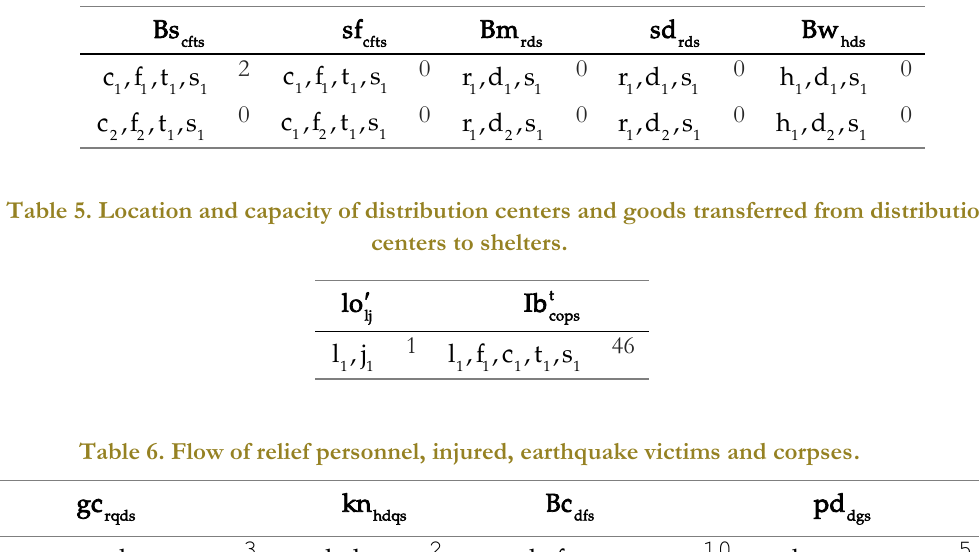
Table 4. Shortage and surplus of goods and relief personnel in shelters and affected areas.